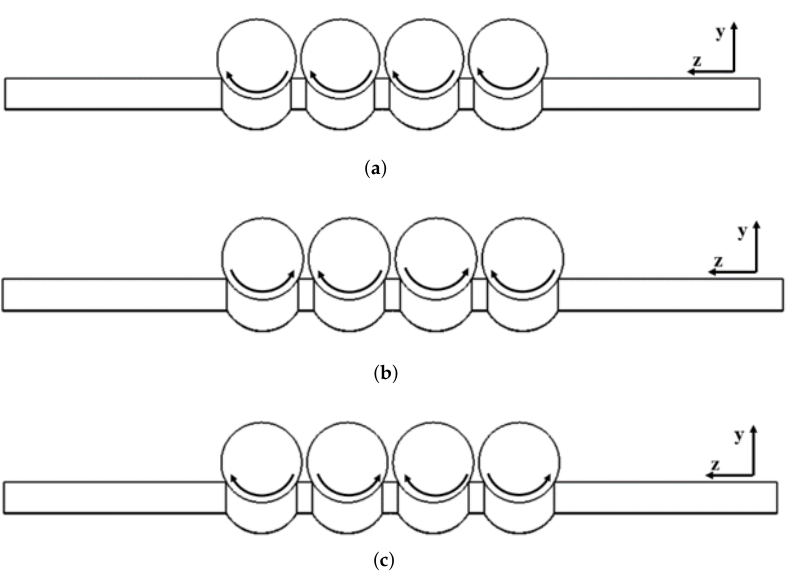
Figure 13. Propeller rotating direction. ( a ) Propeller direction: NNNN (same direction); ( b ) Propeller direction: NPNP (outboard down); ( c ) Propeller direction: PNPN (outboard up).